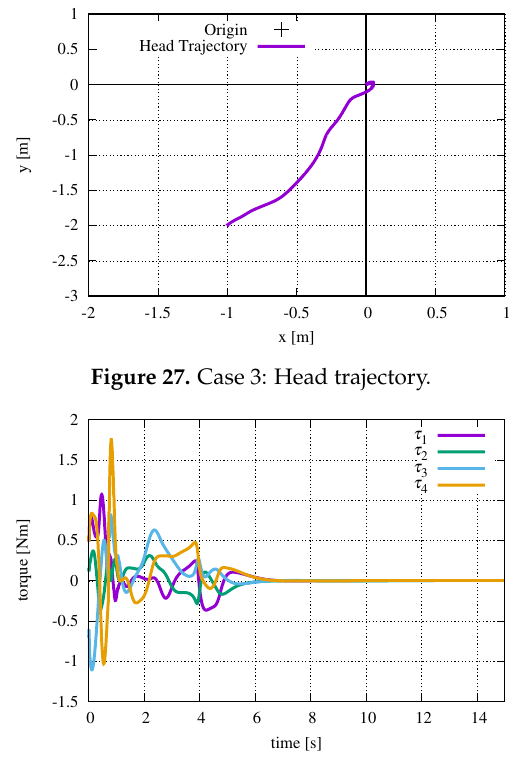
Figure 28. Case 3: Time variation of the input torque.